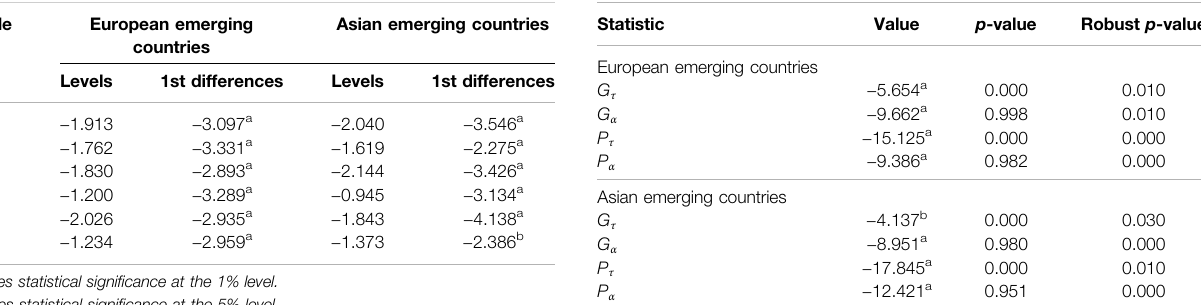
TABLE 3 | Westerlund panel cointegration test